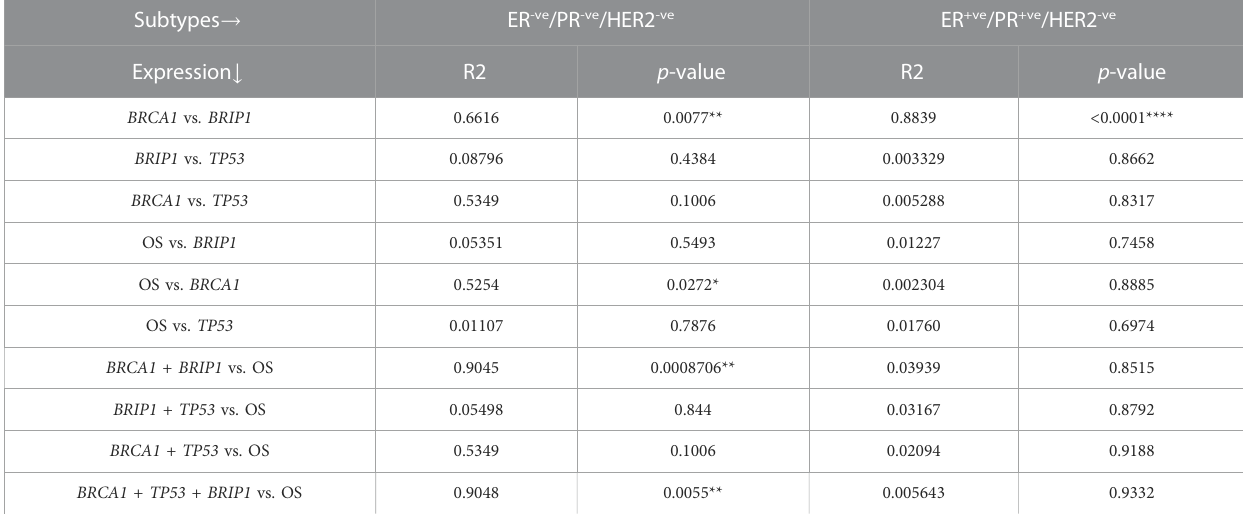
TABLE 3 Association of the m-RNA expression of BRCA1 , BRIP1, and TP53 genes with respect to OS in TNBC and ER/PR +VE breast cancer. Subtypes